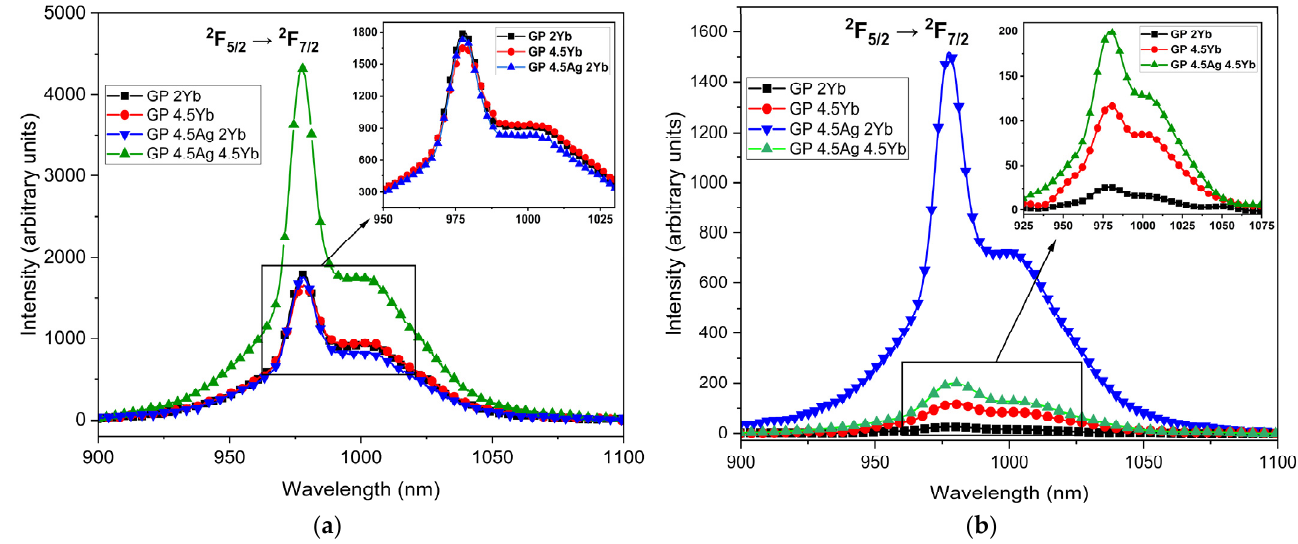
Figure 8. Yb 3+ ions NIR luminescence for GP 2Yb, GP 4.5Yb, GP 4.5Ag2Yb, and GP 4.5Ag4.5Yb samples under ( a ) 355 nm and ( b ) 410 nm excitation.